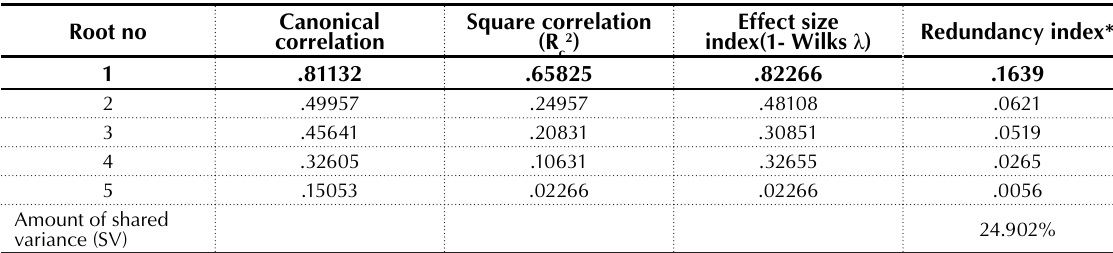
Table 21. Redundancy index and effect of shared